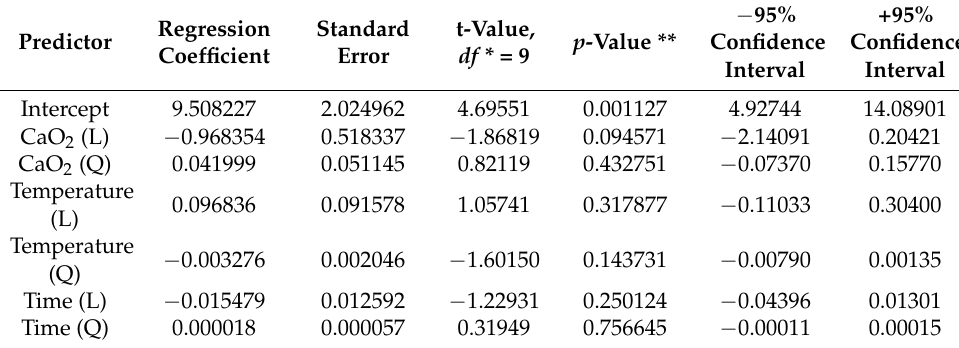
Table 5. Regression coefficients of the inactivation E. coli